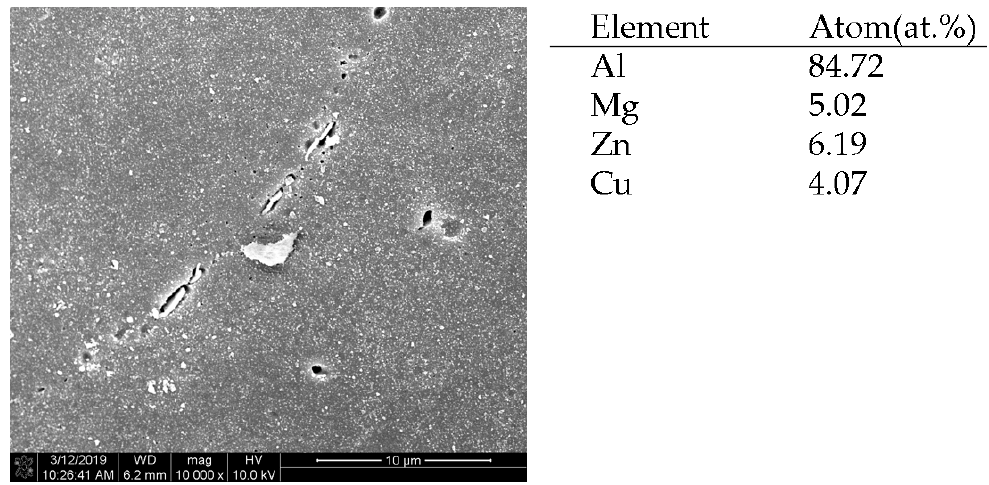
Figure 6. Al–Cu–Mg precipitates located and lined up at the grain boundaries in the matrix of the HC sample.